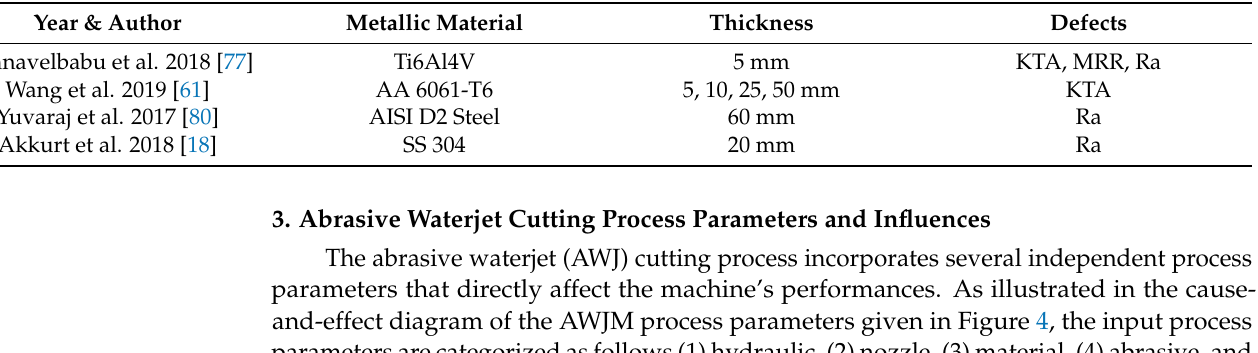
Table 3. AWJ cutting defects amongst various metallic materials [15,62,76–78].